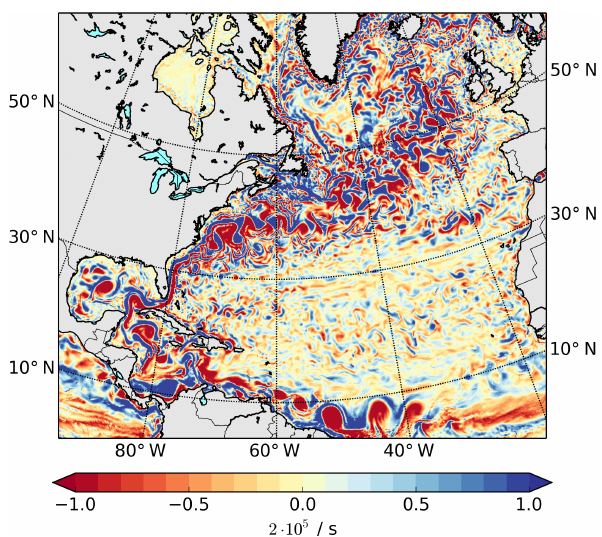
Figure 5. A snapshot of subsurface (40m) relative vorticity for 1 January 2007 from eddy-permitting simulation with FESOM2.0 on the global 15km